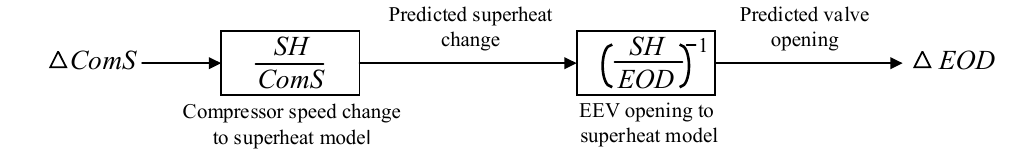
Figure 3. Feedforward control.